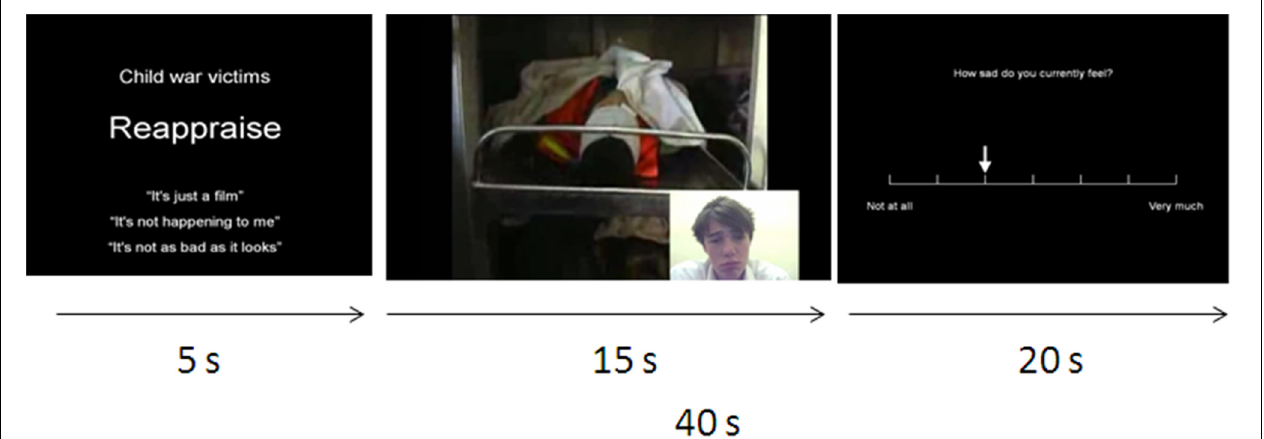
FIGURE 1 | Description of paradigm. In both scans, each trial began with the name of the clip and the instruction type (reappraise, suppress, or watch). Three example phrases for emotion regulation were also provided. Following the onset of the video, participants vocalized their choice of regulatory